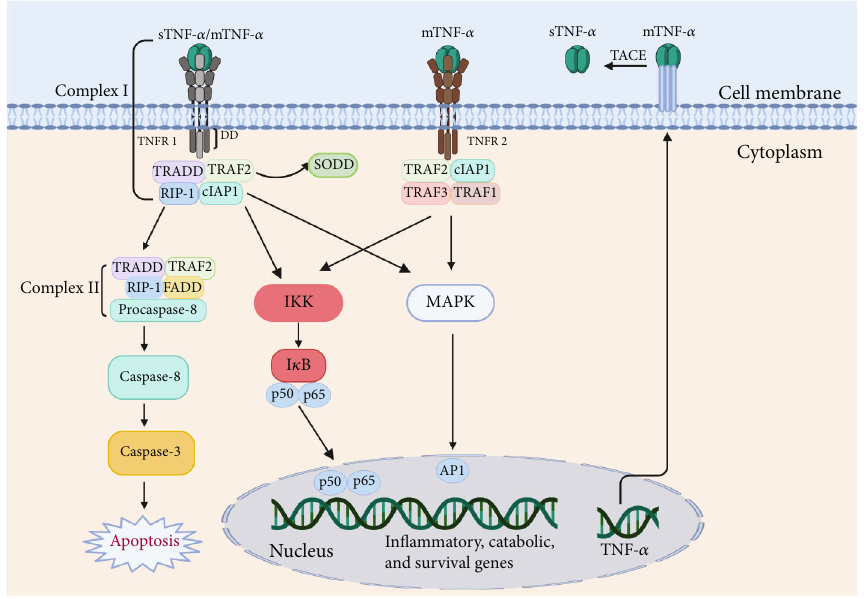
Figure 5: TNF- α signalling